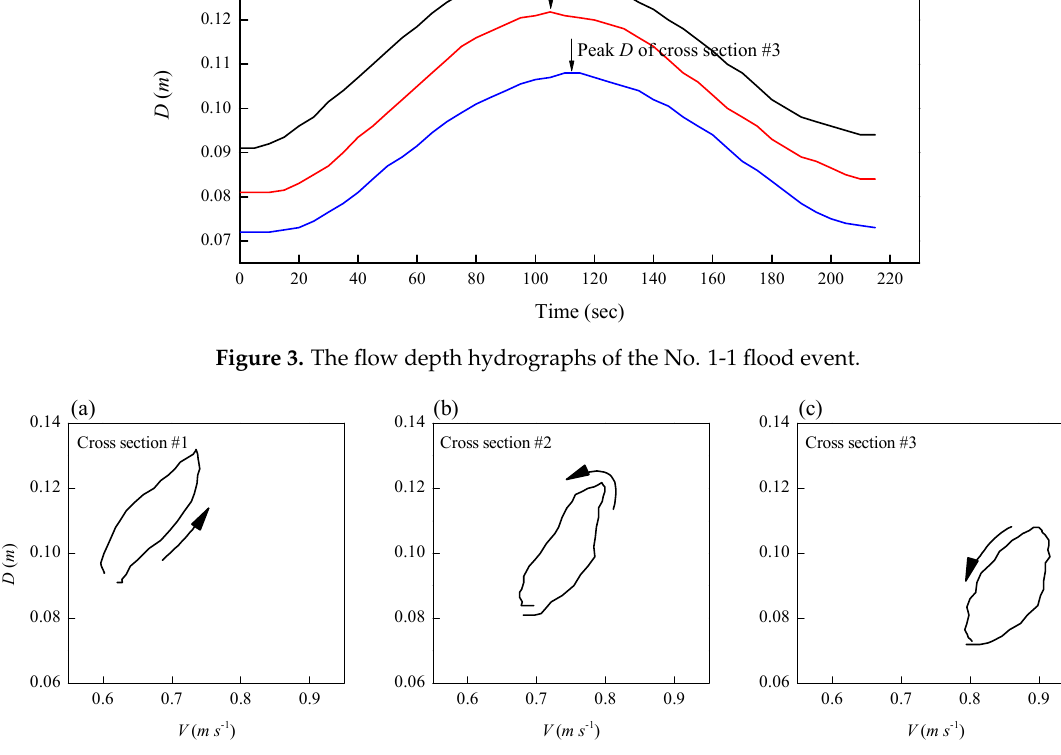
Figure 4. The relationships between cross-sectional averaged velocity and the flow depth at: ( a ) cross section #1, ( b ) cross section #2, and ( c ) cross section #3 in flood event No. 1-1.